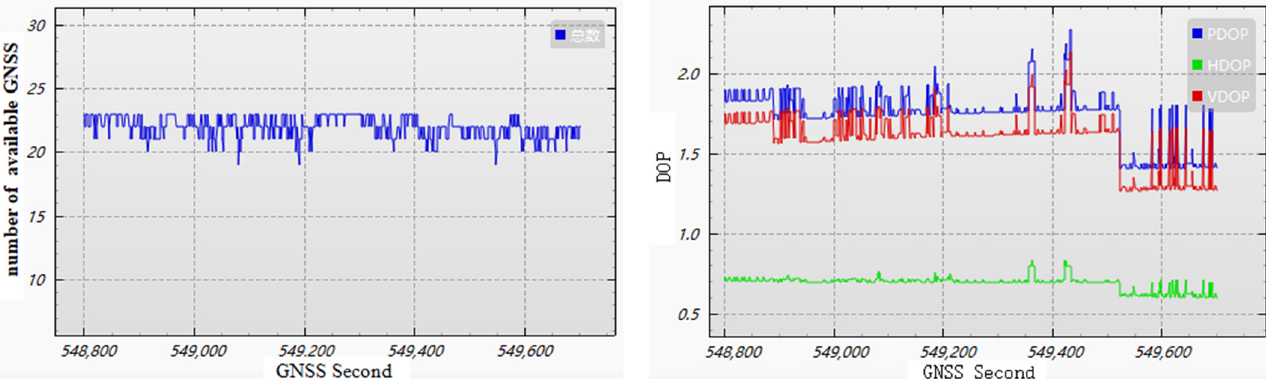
Figure 7. The number of available GNSS satellites and DOP value in the road environment.